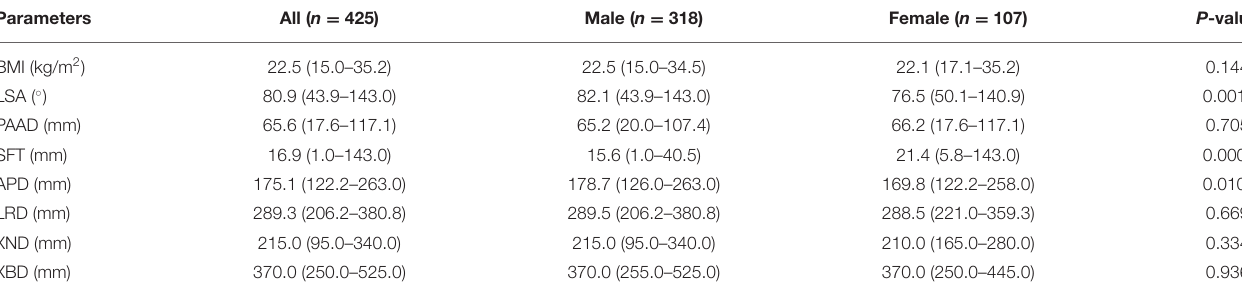
TABLE 2 | Body shape and BMI of the patients.